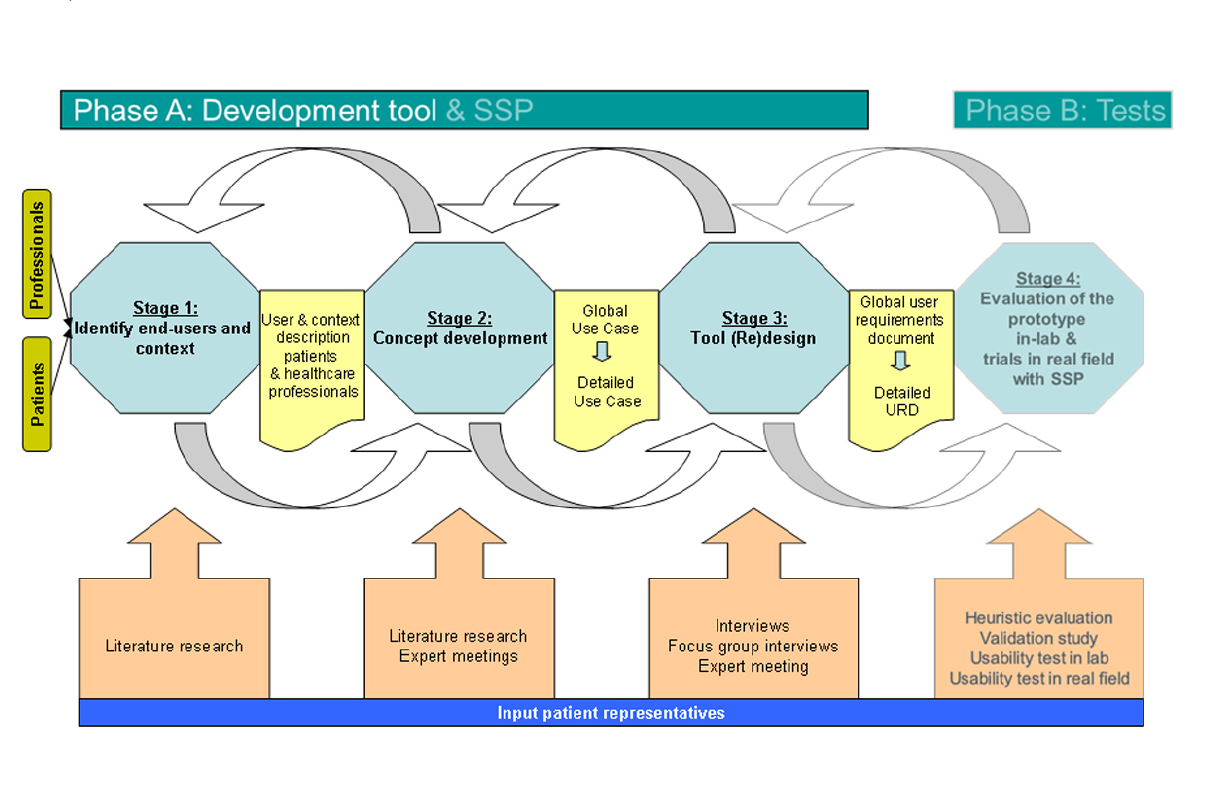
Figure 1. The It’s LiFe! user-centered design process. First the end-users and context were defined based on the literature. Second the conceptual idea of the tool was described in a use case, based on input from literature, an experts meeting and patient representatives. In stage 3 the use case was discussed with patients and health care professionals to elicit the user requirements for the tool. During the whole process the research team deliberated with the engineering team, to find out what was technically possible. After a detailed user requirements document was composed the engineering team translated the user requirements in technical